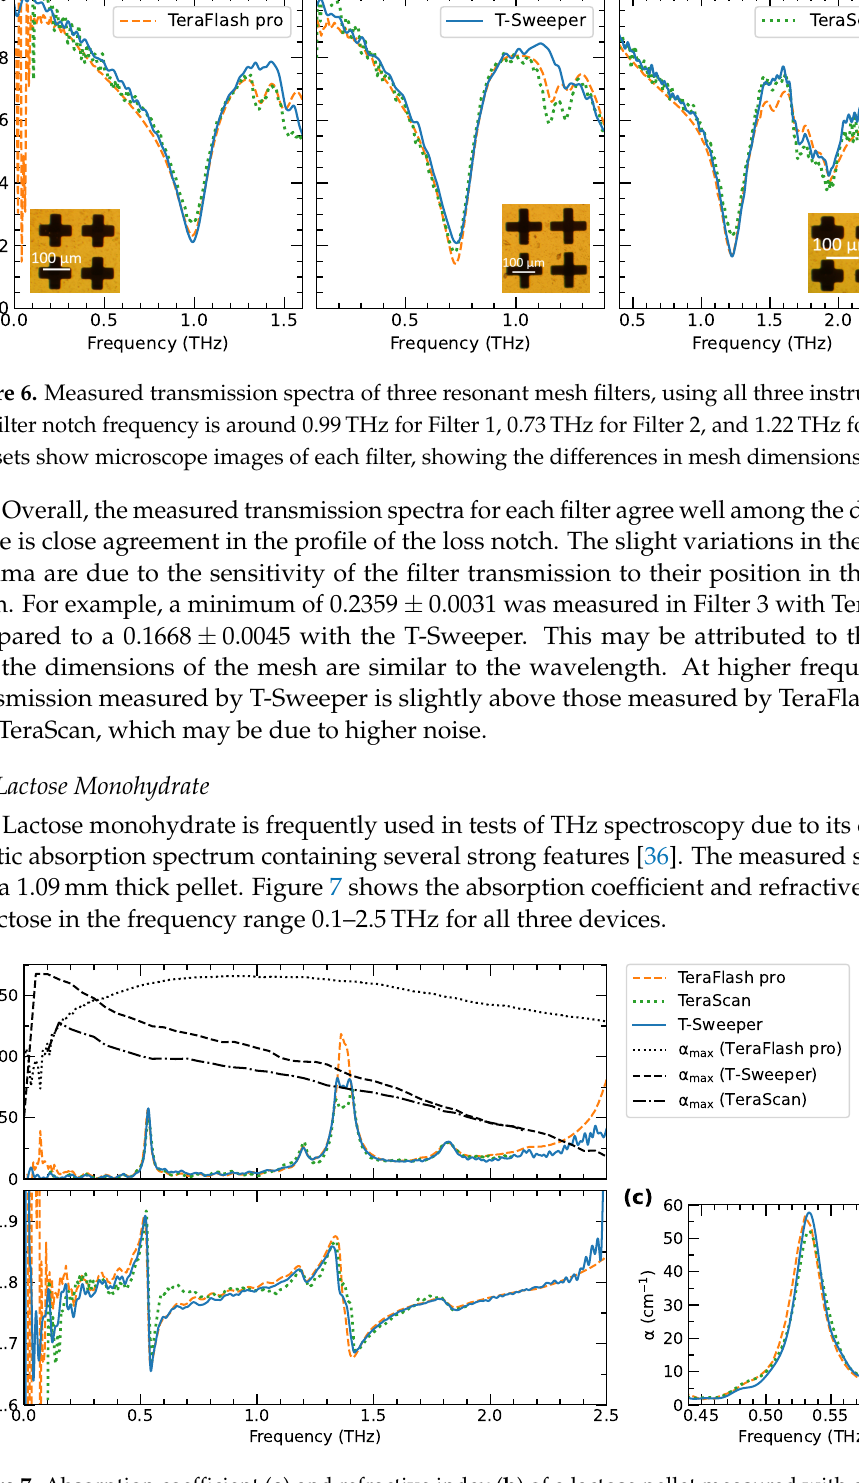
Figure 7. Absorption coefficient ( a ) and refractive index ( b ) of a lactose pellet measured with all three devices. The absorption graph also includes the maximum measurable absorption (cf. Equation (3)); the intersection of α max with the measured absorption curve shows the limits of measurement for each instrument. ( c ) Expanded absorption feature at